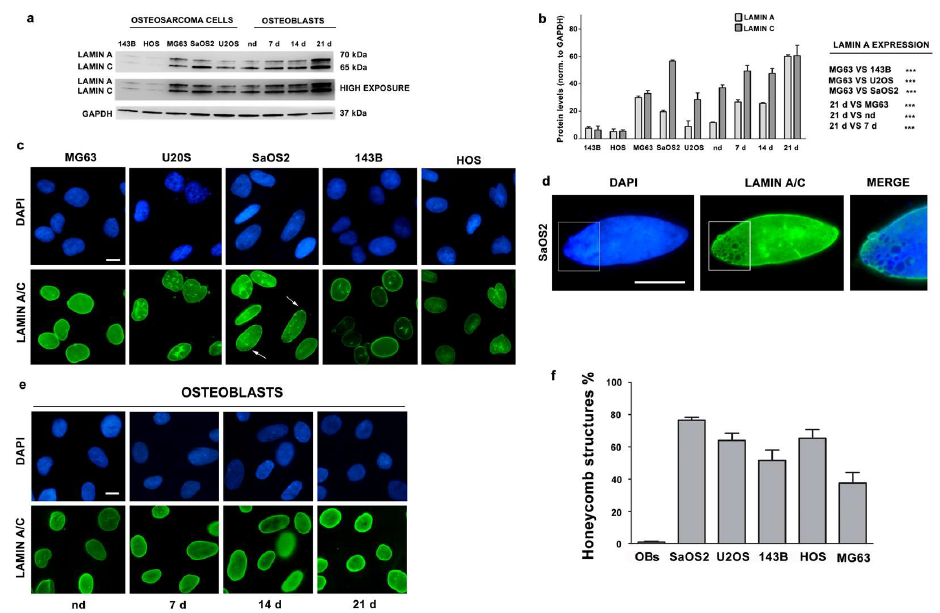
Figure 2. ( a ) Western blotting analysis of lamin A/C in osteosarcoma (OS) cell lines, and OBs from healthy donor differentiated for 7, 14, 21 days in osteogenic medium. nd indicates non-differentiated cells from a healthy donor, cultured 21 days in DMEM plus 10% FBS. ( b ) Densitometric analysis of lamin A/C as mean values ± SD of three different experiments. Asterisks indicate statistically significant differences with respect to 143B cells or nd cells, *** p < 0.001. ( c ) Immunofluorescence staining of lamin A/C in OS cell lines. Arrows indicate honeycomb structures. ( d ) High magnification of a honeycomb structure in a SaOS2 nucleus. The area indicated in the rectangle is shown at higher magnification in the merged image (merge). ( e ) Immunofluorescence staining of lamin A/C in osteoblasts (OBs) from healthy donors differentiated for 7, 14 or 21 days in osteogenic medium. ( f ) Percentage of honeycomb structures detected in osteoblasts at all differentiation stages or in osteosarcoma cells. Mean of values ± SD are plotted. Cells in c, d and e were labeled using anti-lamin A/C antibody and revealed by an AlexaFluor 488 secondary antibody (green). DNA was stained with DAPI (blue). Scale bars, 10 μm.